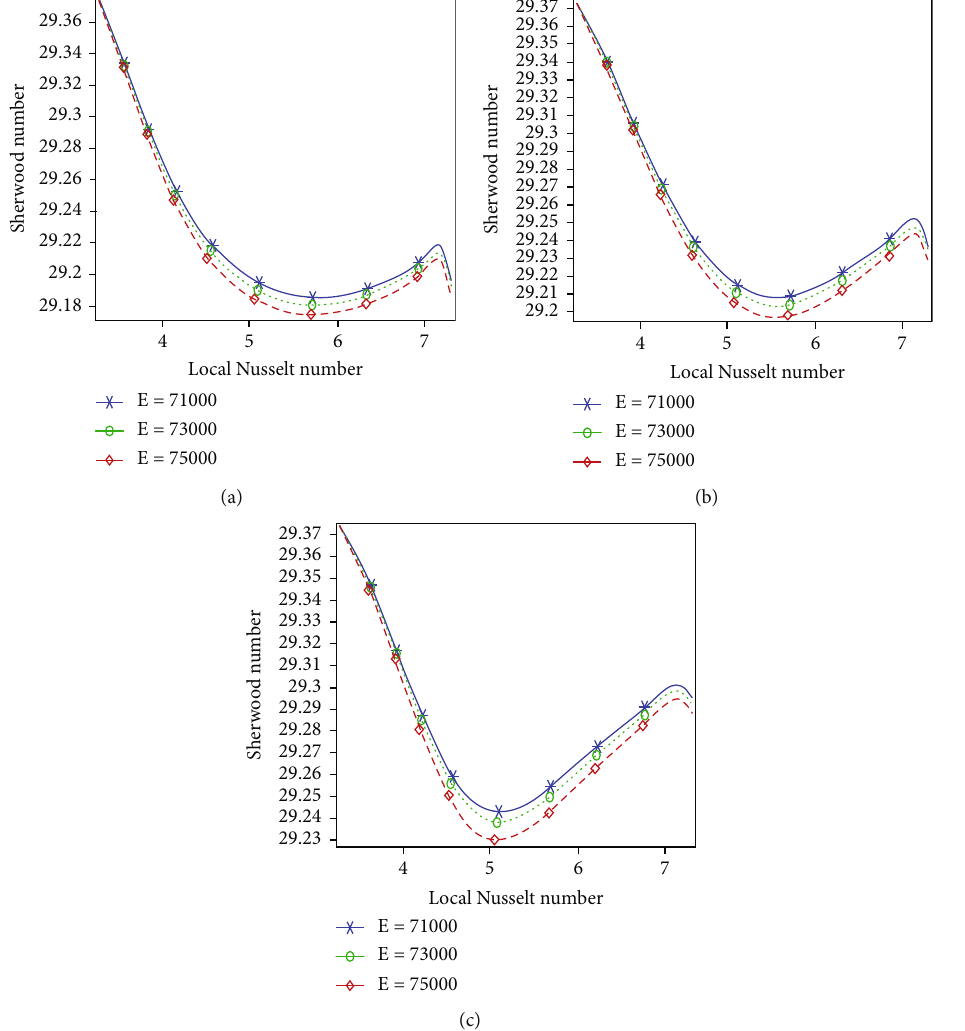
Figure 19: Sherwood number vs. the local Nusselt number at downstream along the backward step channel against the axial direction at (a) Re = 100 , I : C = 3 % , a = 0 : 5 ; (b) Re = 100 , I : C = 3 % , a = 0 : 6 ; and (c) Re = 100 , I : C = 3 % , a = 0 : 7